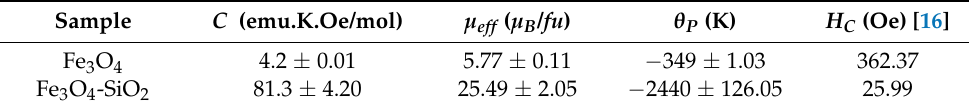
Figure 4. The fitting of Curie–Weiss law on 𝑀 (cid:3007)(cid:3004) data of Fe 3 O 4 ( a ) and Fe 3 O 4 -SiO 2 ( b ).